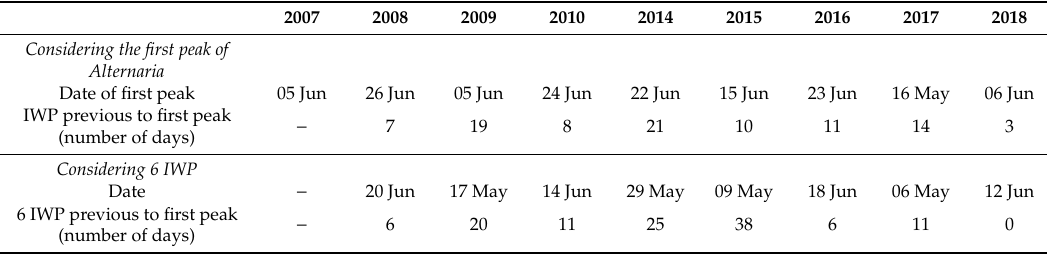
Table 2. Number of days and date with interrupted wet periods (IWP) considering the first peak Alternaria and the days with 6 IWP by crop